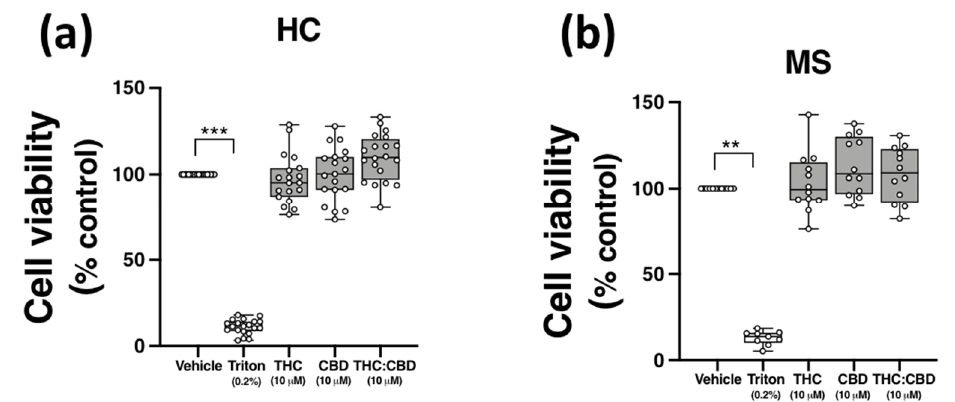
Figure 5. THC and CBD are not cytotoxic in PBMCs from HCs and pwMS. MTT assay of PBMCs from ( a ) HCs, and ( b ) pwMS treated (for 24 h) with THC (10 µ M) alone, CBD (10 µ M) alone and THC:CBD in a 1:1 combination (10 µ M:10 µ M). The number of control cells, i.e., viable cells exposed to vehicle (0.1% ethanol), was defined as 100% in each participant. Triton X-100 (0.2% for 10 min) treatment was used as a positive control. Kruskal–Wallis statistic = 54.5 in HC samples. Kruskal–Wallis statistic = 25.1 in MS samples. Data are presented as median viability values expressed as % control, minimum and maximum values and IQR. Symbols indicate individual data points in PBMCs from 20 HCs and 12 pwMS. Statistical significance was determined by Kruskal–Wallis tests, with Dunn’s multiple comparison post-hoc test. ** p < 0.01, *** p < 0.001 vs. vehicle control